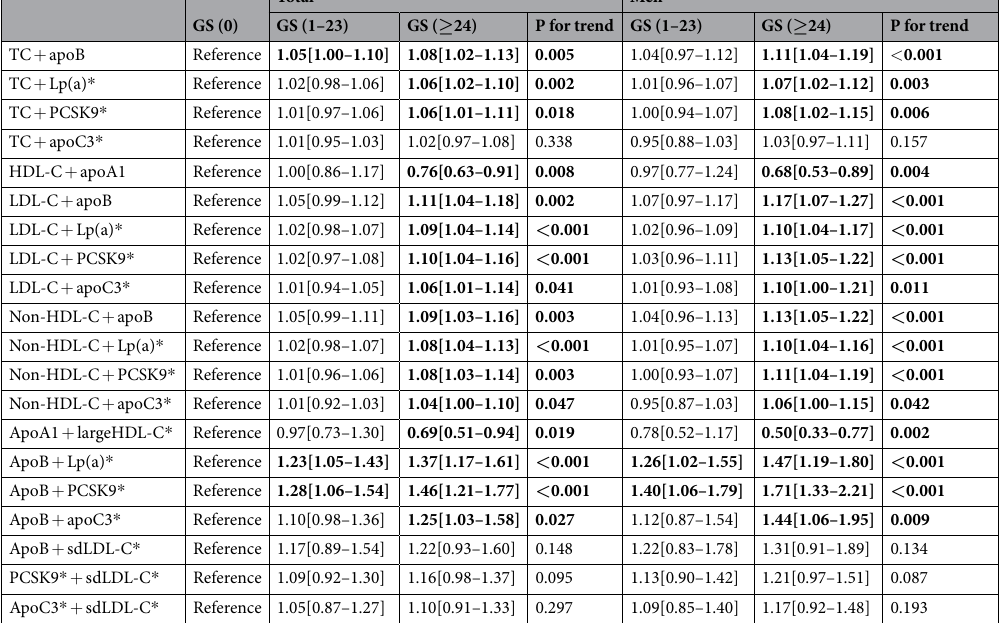
Table 5. The interactions between lipid biomarkers on coronary severity using logistic regression analysis. Multiple logistic regression analyses were performed and ORs [95% CIs] were showed with adjustment for age, gender, hypertension, HbA1c, current smoking and hs-CRP. The interaction terms as Table 4. The bold values indicated statistical significance and were bolded to improve the readability of the table. * Log-transformed data. Abbreviations as Table